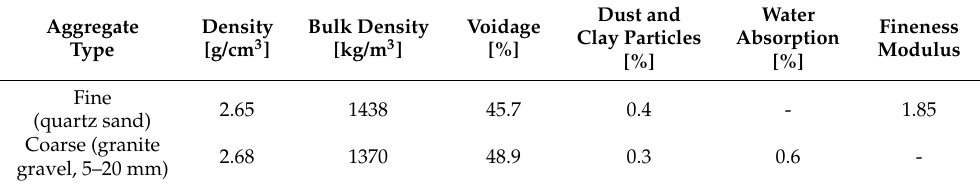
Table 2. Properties of aggregates.